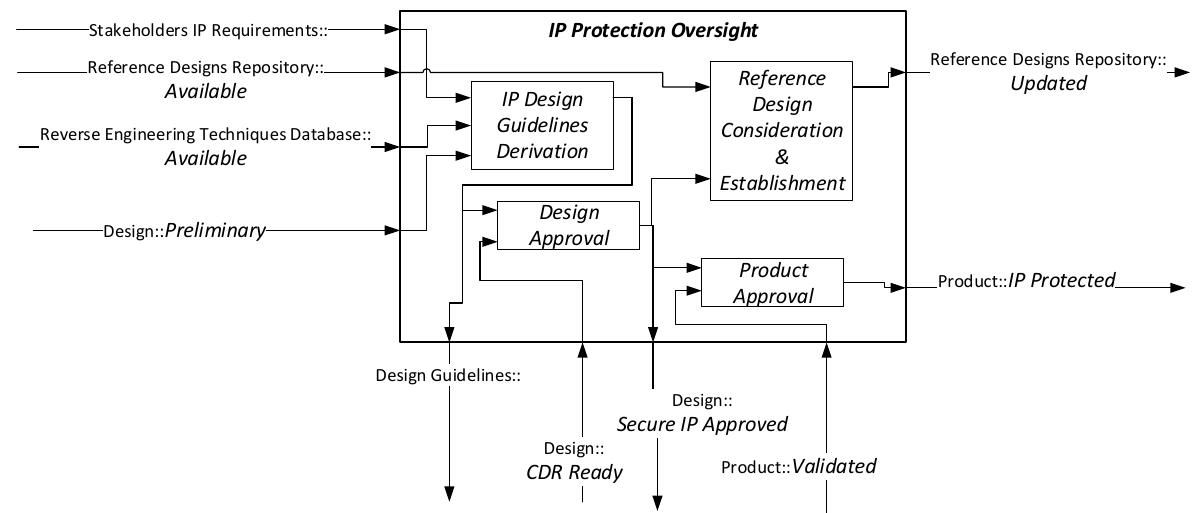
Figure 13. PROVE diagram of the Intellectual Property (IP) Protection Oversight case study (adopted from [24]).